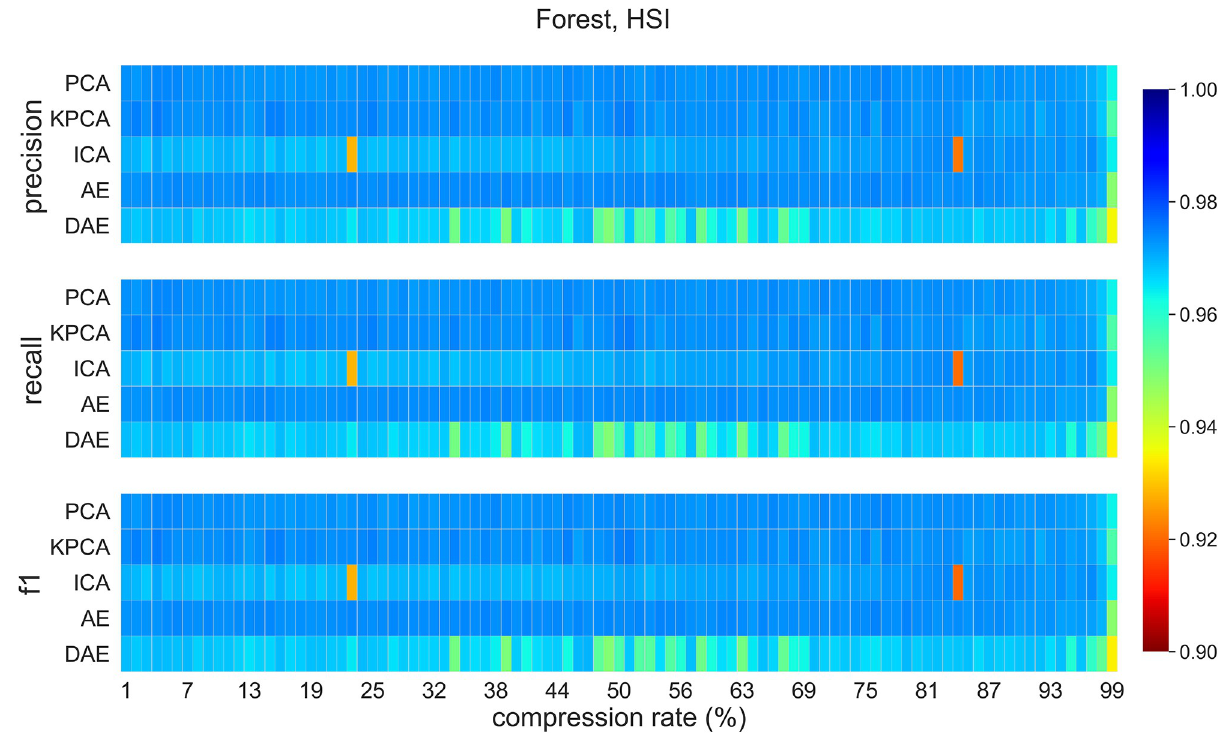
Fig 11. Forest dataset classification scores for all methods for compression rates between 1% to 99%.